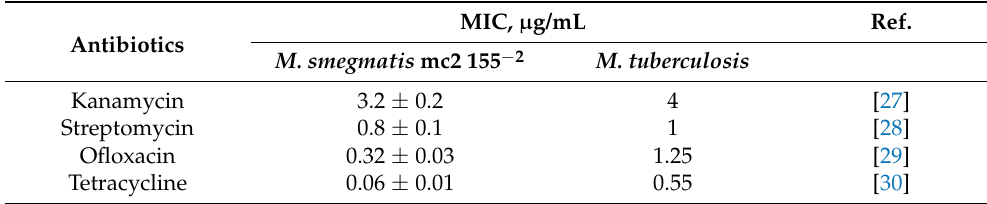
Table 1. The MICs of the antibiotics on M. smegmatis and M. tuberculosis . Data for M. smegmatis were obtained in this paper. Data for M. tuberculosis were taken from open sources. MIC, µ g/mL Antibiotics